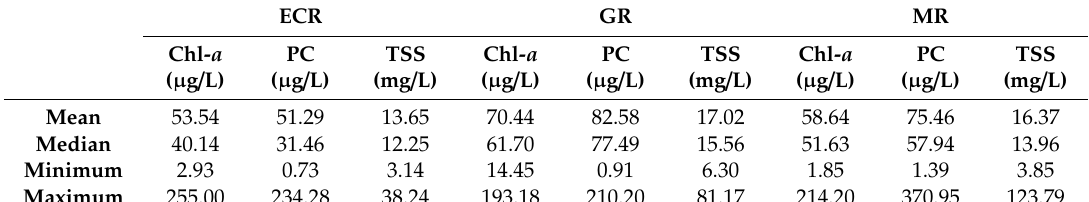
Table 2. Limnological variables for central Indiana reservoirs ECR, GR, and MR.